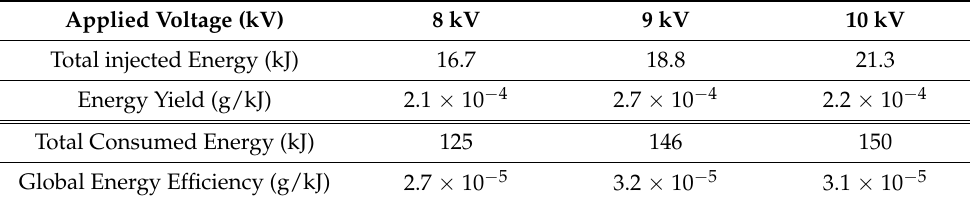
Table 4. Energy balance of the PLI process for Cr(VI) reduction by pin-to-pin discharges (47 mg/L, σ = 4 mS/cm, pH = 2.3), V = 100 mL, ∆ t = 500 µ s, electrode length = 0 ± 10 µ m, gap = 2 mm, f = 50 Hz. The total reduction is obtained in 120 min for 8 and 9 kV and in 105 min for 10